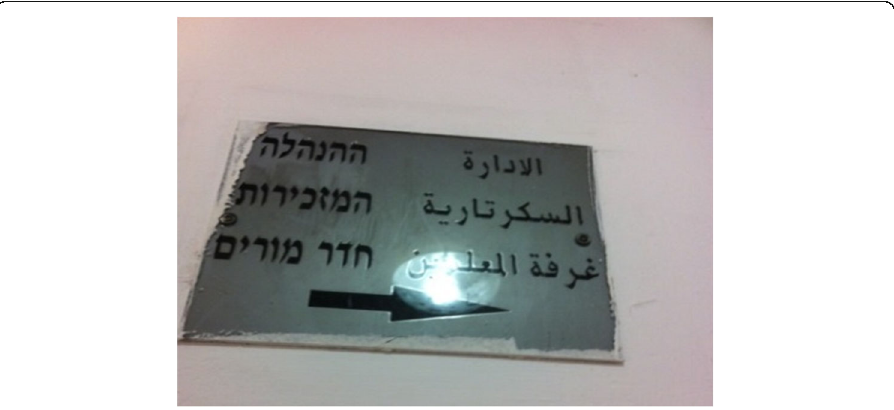
Fig. 9 An infromative sign concerning the location of the school